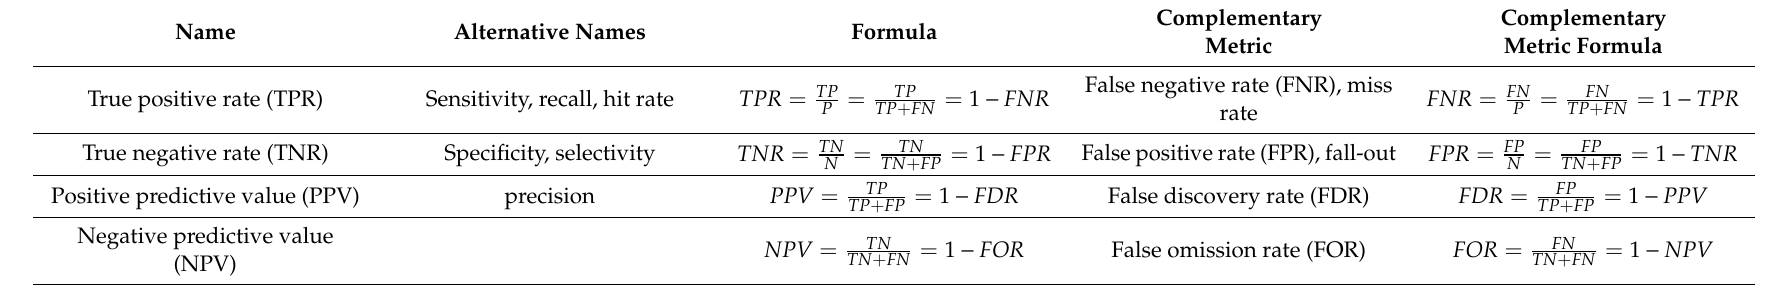
Table 4. Local performance metrics for 2-class classification—One-sided.